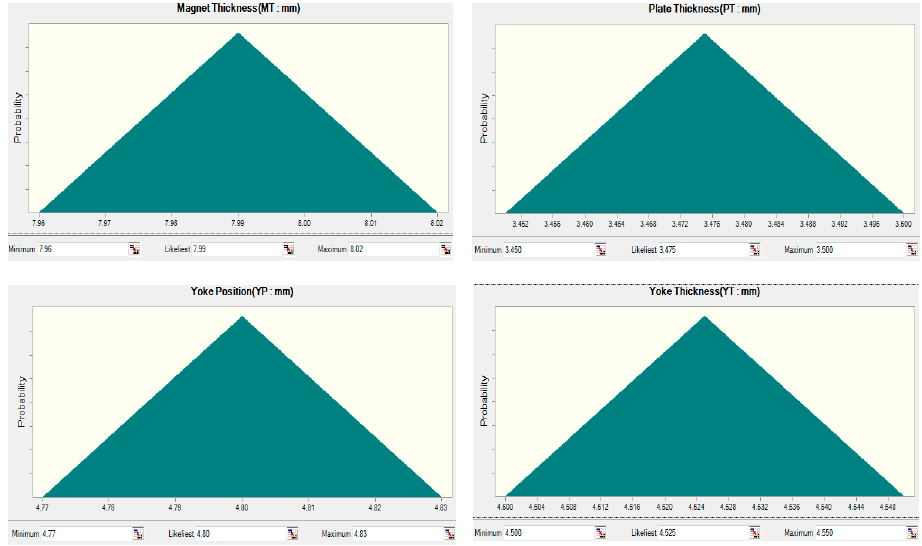
Figure 16. Probability distribution of vertical magnetized structure performance factor in design tolerance. Scheme 17. The performance distribution of electromagnetic force by design